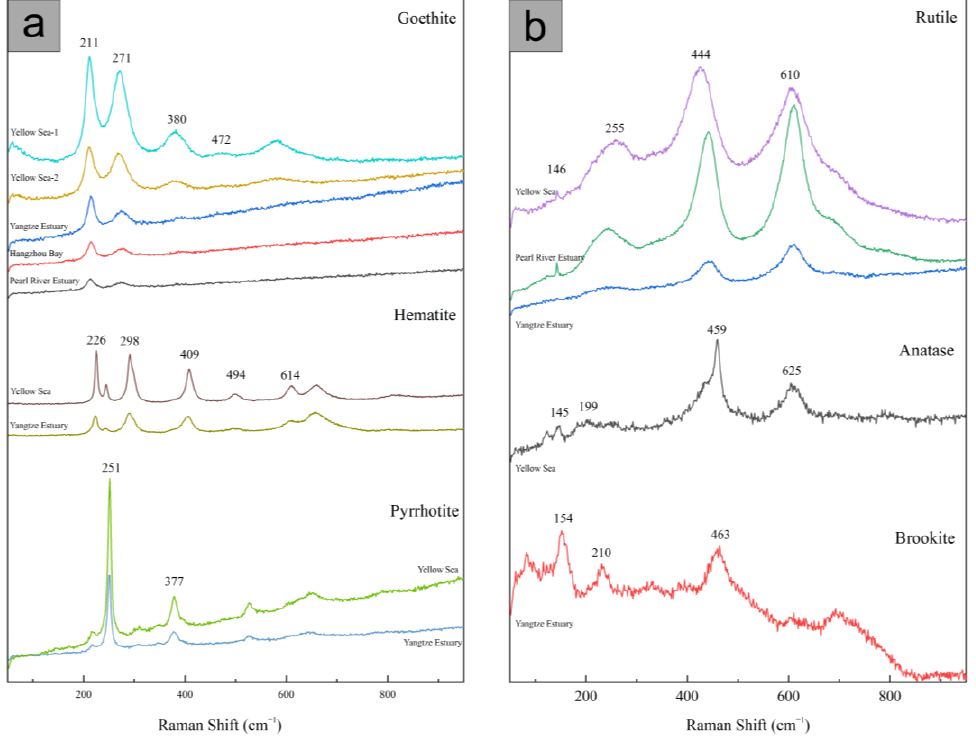
Figure 4. Raman spectra of suspended particulate matters. ( a ) Iron oxide and iron sulfide; ( b ) tita- nium oxide.